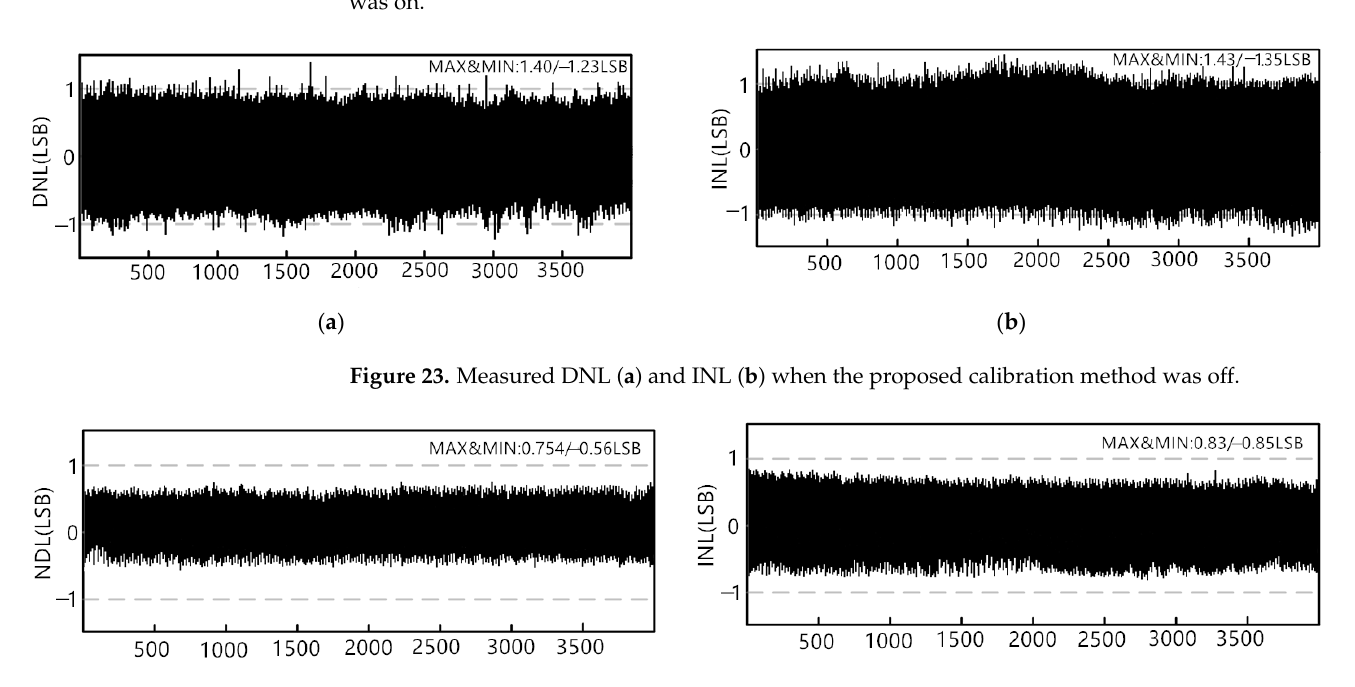
Figure 22. Measured Spectrum at Fin = 49.96 MHz when ( a ) calibration was off and ( b ) calibration was on .